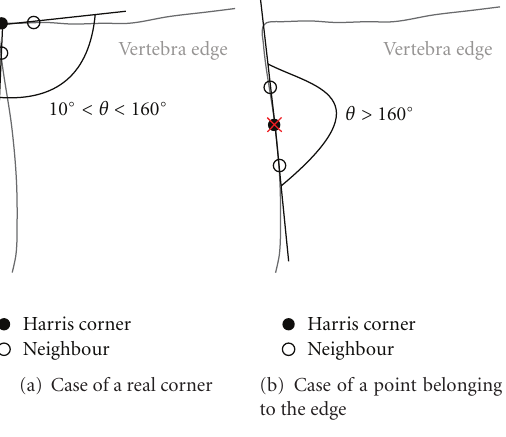
Figure 7: The angle filter process.